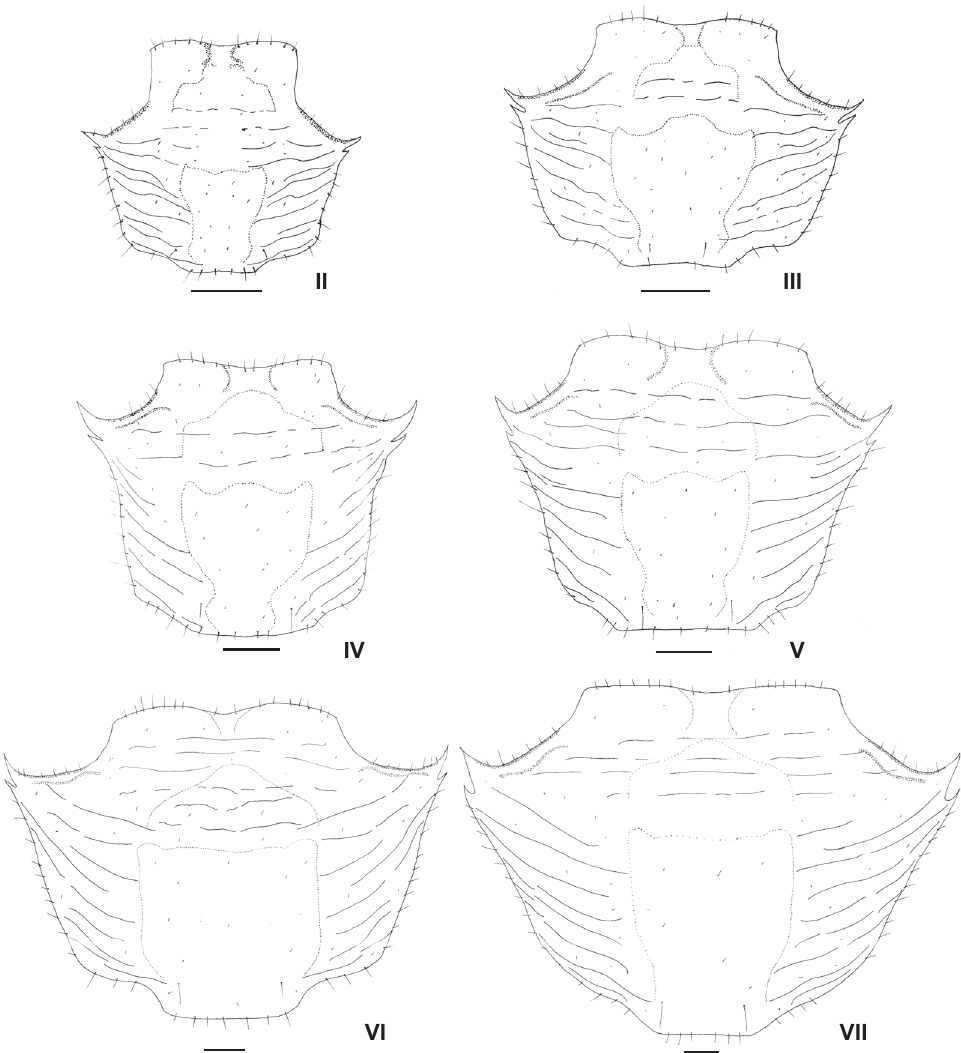
Figure 30. Pachygrapsus gracilis , juvenile instars. Carapace from juvenile instar II to VII. Scale bars: Juvenile instars II, IV-V = 0.7 mm; Juvenile instars III = 0.6 mm; Juvenile instar VI-VII = 0.5